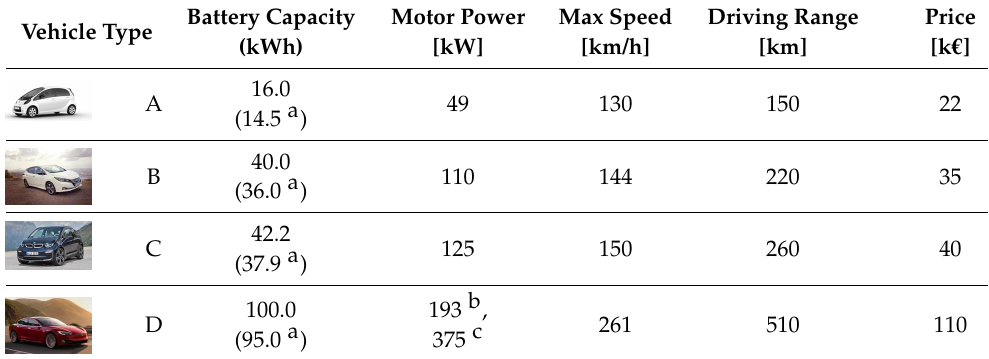
Figure 8. EV market sales for 2021 in Spain [26]. Table 1. Characteristics of vehicles considered.